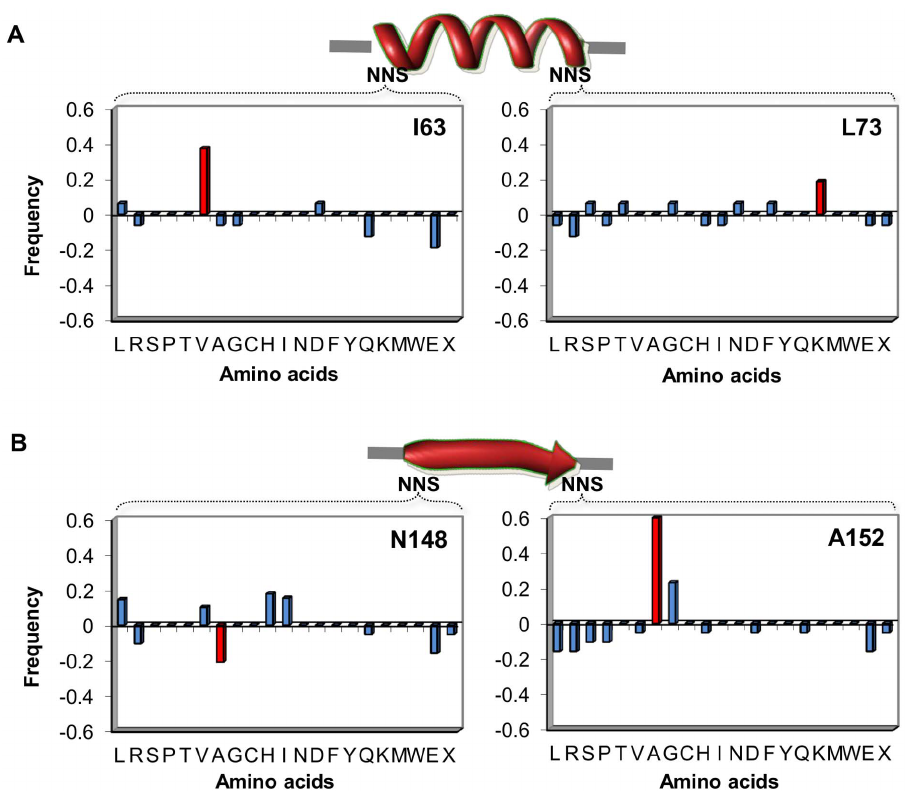
Figure 3. Sequence analysis under selective pressure at variable positions in chimera enzymes. Amino acids are represented by the one code letter. The histograms represent the relative frequencies of the selected versus unselected libraries. The red colored histograms (*) represent those amino acids at the variable positions that had a frequency either significantly higher (2 standard deviations) or lower than expected by chance. The sequence analysis for the a -helix 3 and b -strand 7 from MetR swapped into the TrpF scaffold are shown in A and B, respectively. The variable positions are represented by the NNS codon. The three-dimensional structure of the E. coli enzyme (PDB: 1PII) was used to identify the variable positions. The amino acid numbering of TrpF is according to gene reported in [25].